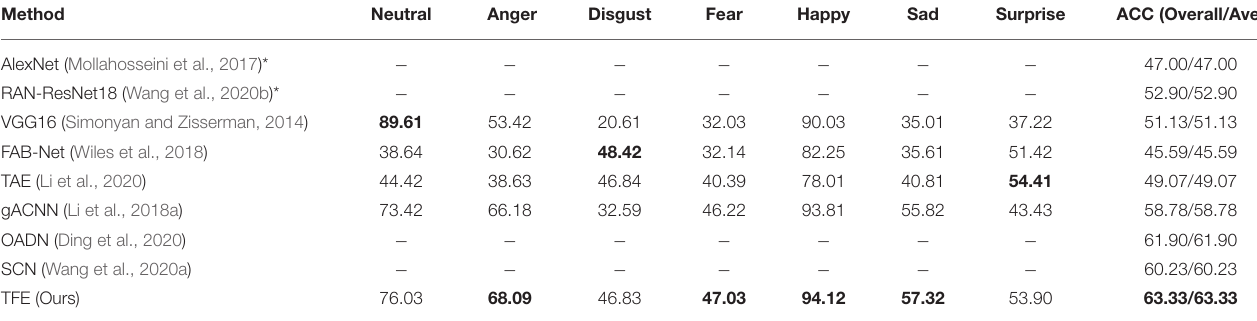
TABLE 2 | Validation set accuracy on AffectNet dataset.